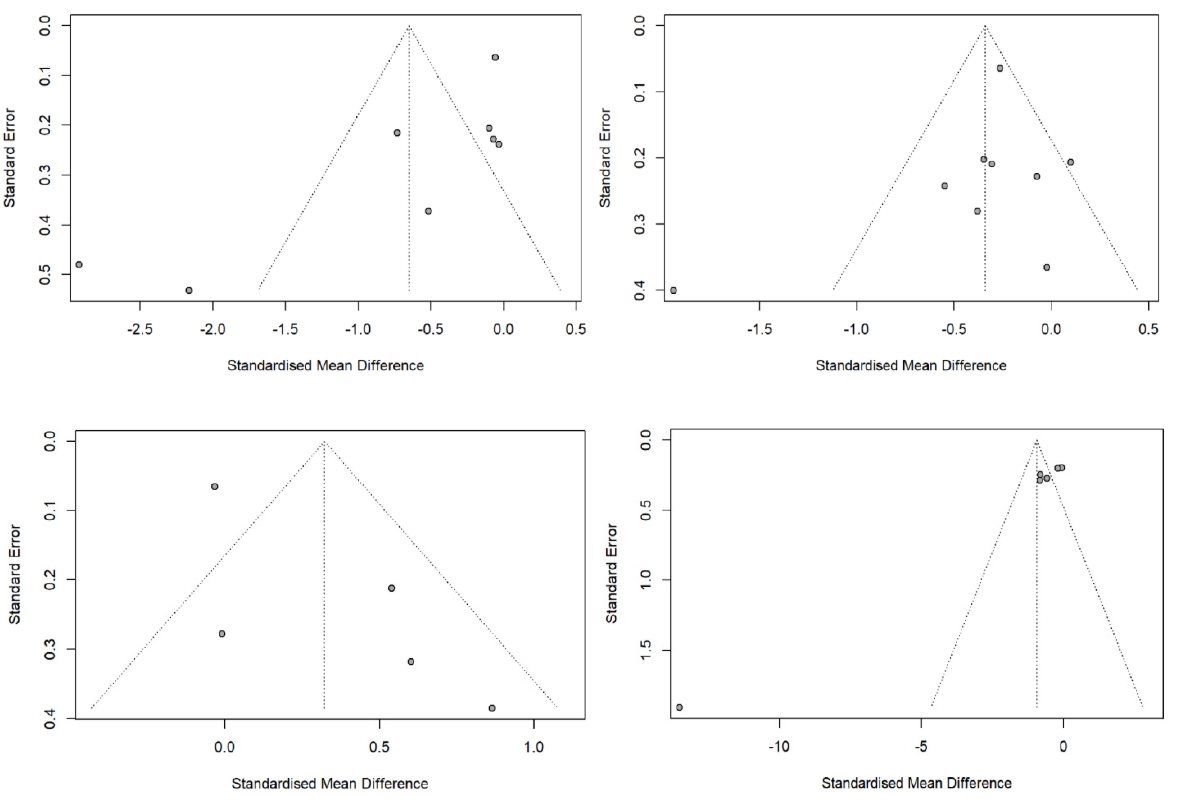
Figure 6. Funnel plots of the SMDs resulting from forest therapy. The SMDs appear asymmetrical for all outcomes. SMD, standardized mean difference.